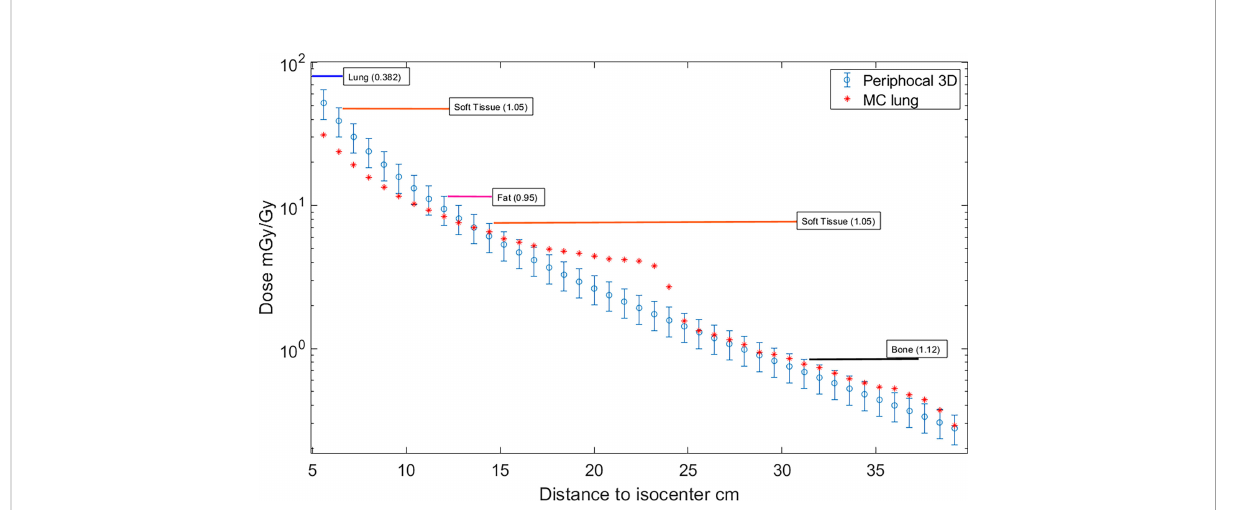
FIGURE 6 Absorbed dose, expressed as peripheral dose (mGy), calculated by Periphocal 3D and MC for the lung case, relative to the isocentric dose (Gy). Displayed symbols correspond to points along the craniocaudal axis (towards the phantom ’ s feet) at the isocenter depth. The uncertainties of the MC dose values are within the size of the symbols. It has also been displayed the type of tissue together with the corresponding electronic density in which calculations were performed (e.g., from 7 cm to 12 cm far from the isocenter is soft